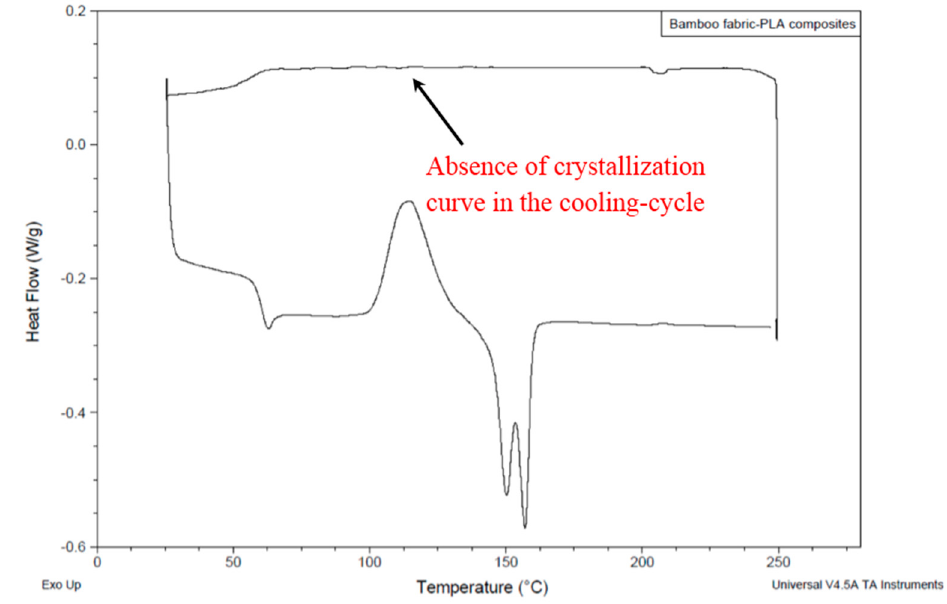
Figure 7. DSC trace of bamboo fabric-PLA composites.